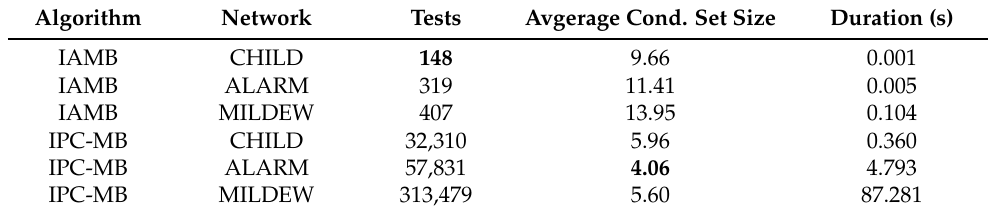
Table 1. Overall d-separation test count and average conditioning set